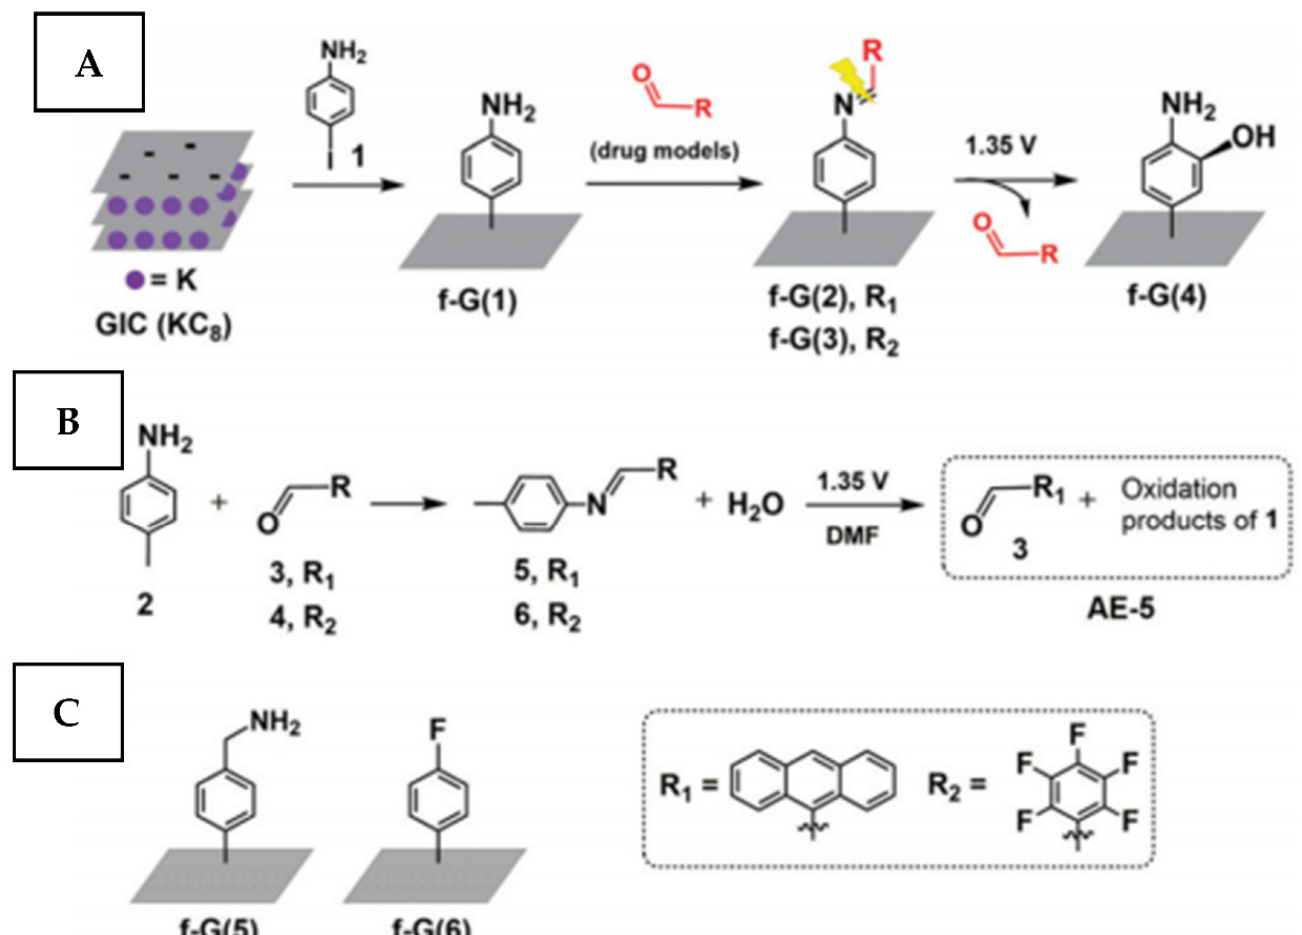
Figure 10. A scheme of the preparation of ( A ) a graphene-based platform f-G(1) loaded with drug models (f-G(2–3)) followed by their electrochemically triggered release (f-G(4)); ( B ) graphene-free organic models employed to characterize the release mechanism; ( C ) graphene-based materials for control experiments. Reprinted from ref. [137] with permission from the Royal Society of